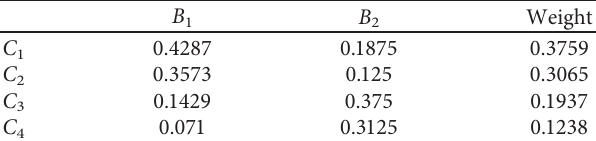
Figure 7: Tomographic structure model. Table 2: The weight of each